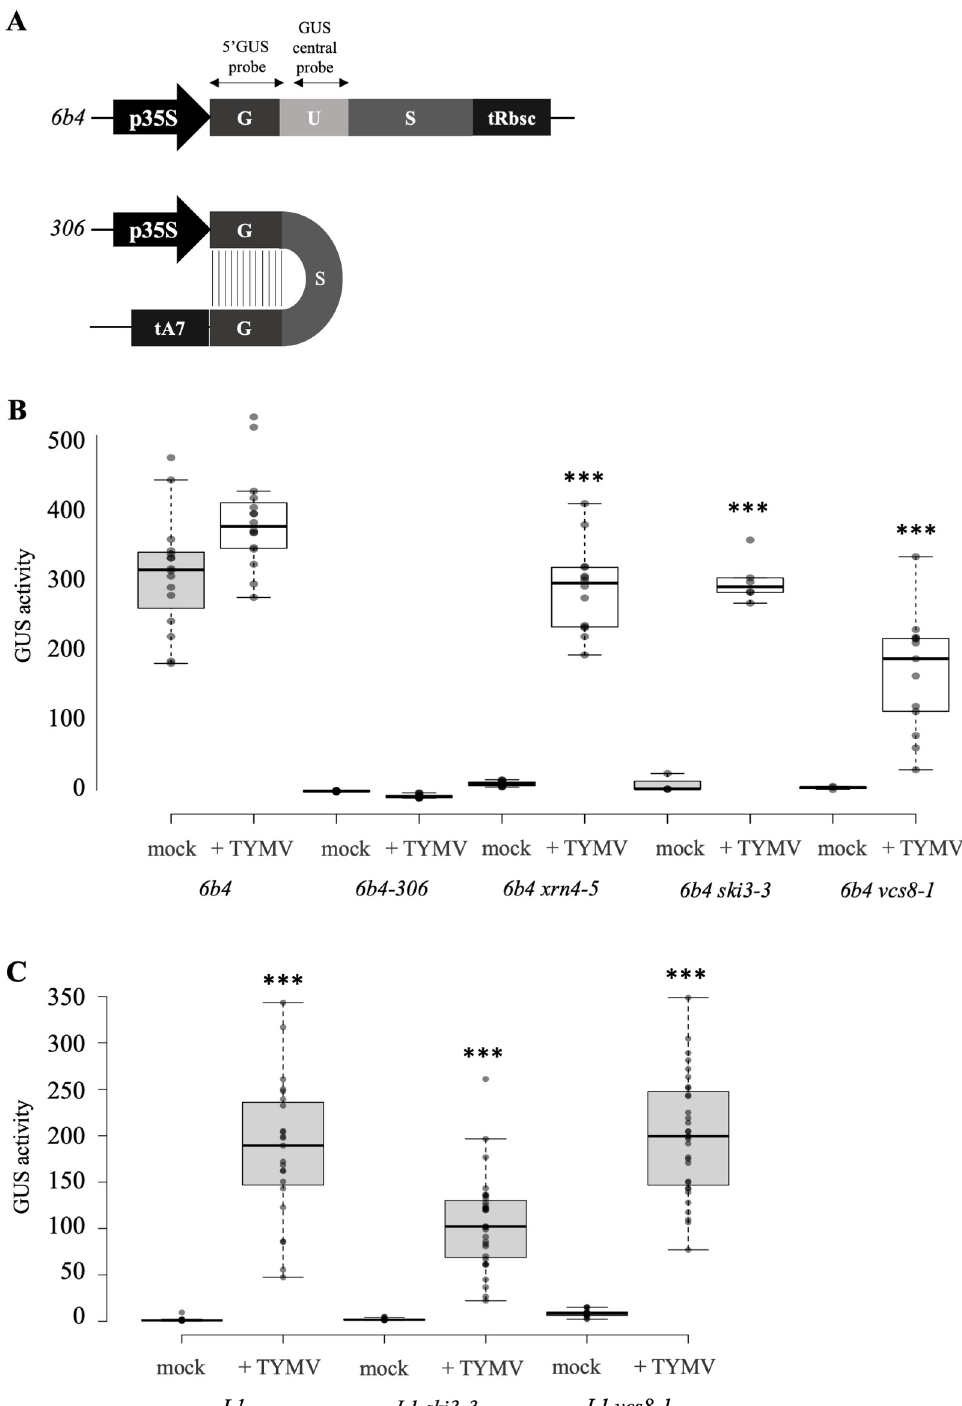
Fig 2. TYMV inhibits S-PTGS but not IR-PTGS. A) Scheme of the p35S : GUS and p35S : hpG in 6b4 and 6b4-306 transgenic lines. Probes used for northern blot revelation are indicated. B) and C) GUS activity in transgenic Arabidopsis lines infected with TYMV. Plants were grown in long day conditions. GUS activity was measured three weeks after infection and is expressed in arbitrary unity of fluorescence/ug of protein/minutes. 3 stars indicate a student test with a significant level < 0.01 between mock and infected